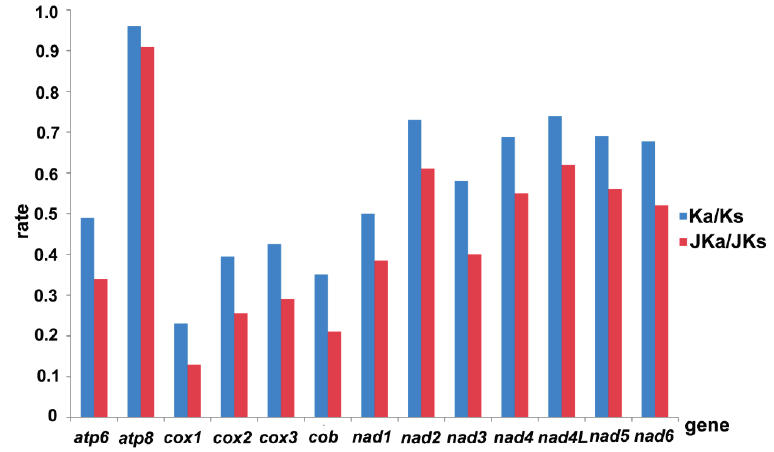
Figure 4. Evolutionary rates of protein-coding genes in hemipteran mitogenomes. The blue bar indicates the gene’s Ka/Ks, and the red bar indicates the Jukes-Cantor adjusting